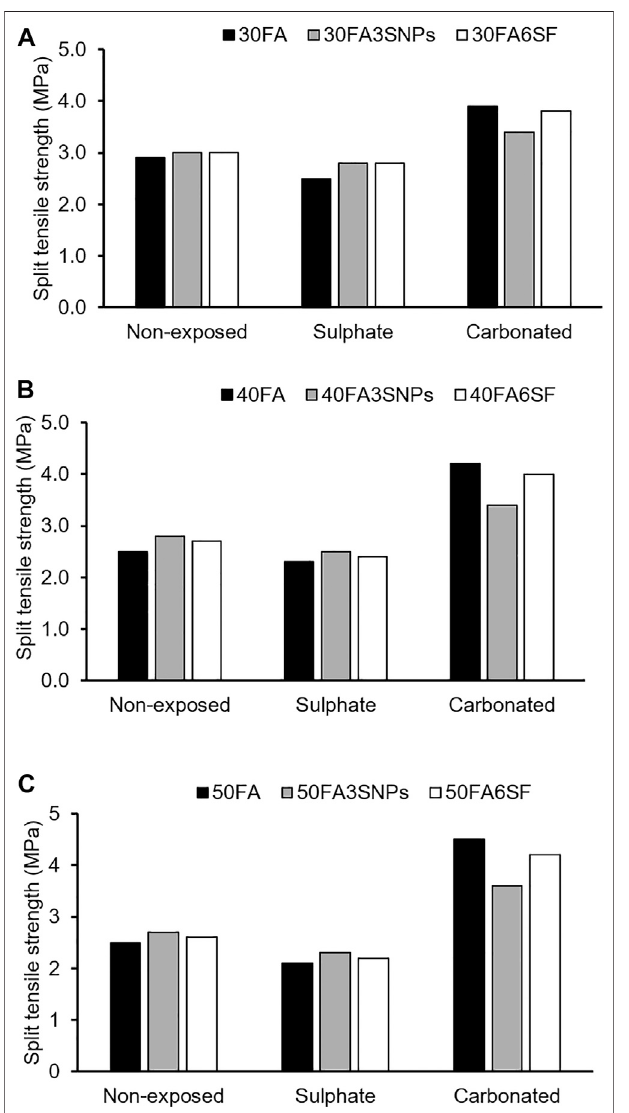
FIGURE 3 | The split tensile strength of exposed and non-exposed (A) 30% fl y ash containing 3% SNPs and 6% SF (B) 40% fl y ash containing 3% SNPs and 6% SF and (C) 50% fl y ash containing 3% SNPs and 6% SF incorporated concrete samples after 365 days of exposure.